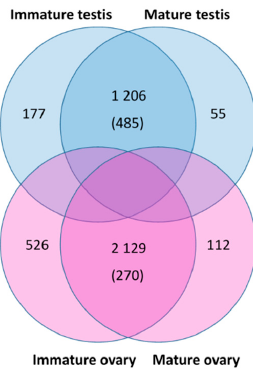
Figure 5. Venn diagram of di ff erentially expressed genes between testis and ovary samples of di ff erent life stages. Comparison of immature and mature testis samples (blue) identified 177 di ff erentially expressed genes (DEGs) enriched in the immature testis and 55 DEGs enriched in the mature testis samples. Comparison of immature and mature ovary samples (pink) identified 526 DEGs enriched in the immature ovary and 112 DEGs enriched in the mature ovary samples. Comparison of testis and ovary samples identified 1206 DEGs enriched in the testis (of which 485 transcripts are testis-specific) and 2129 DEGs enriched in the ovary (of which 270 transcripts are